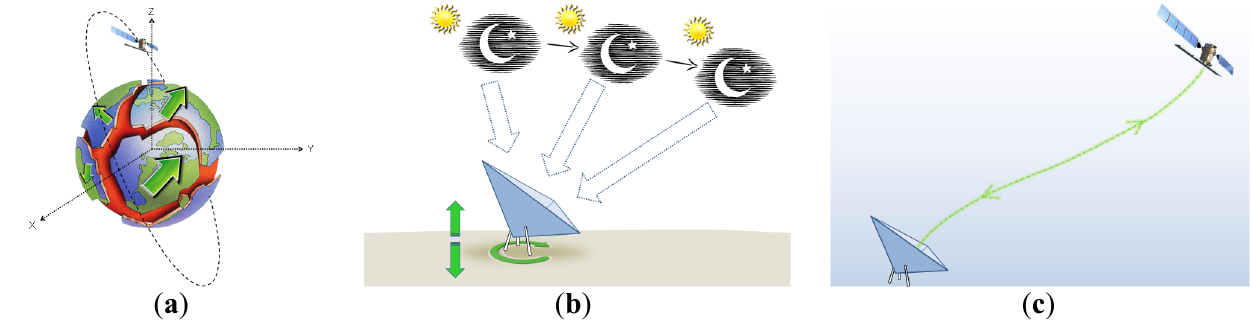
Figure 4. The three largest perturbations affecting the position of a surveyed reference target in a SAR image: ( a ) drift between local and global coordinate frames caused by plate tectonics; ( b ) solid Earth tide; and ( c ) atmospheric path